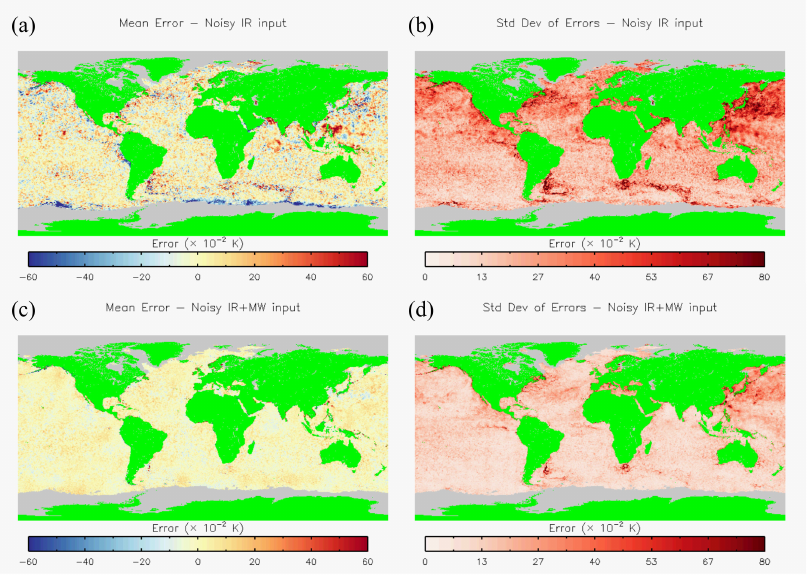
Figure 9. Maps of the error statistics during July for input data with realistic errors: ( a ) mean error with IR data only, ( b ) standard deviation of the error with IR data only, ( c ) mean error with combined IR and CIMR data and ( d ) standard deviation of the error with combined IR and CIMR data.